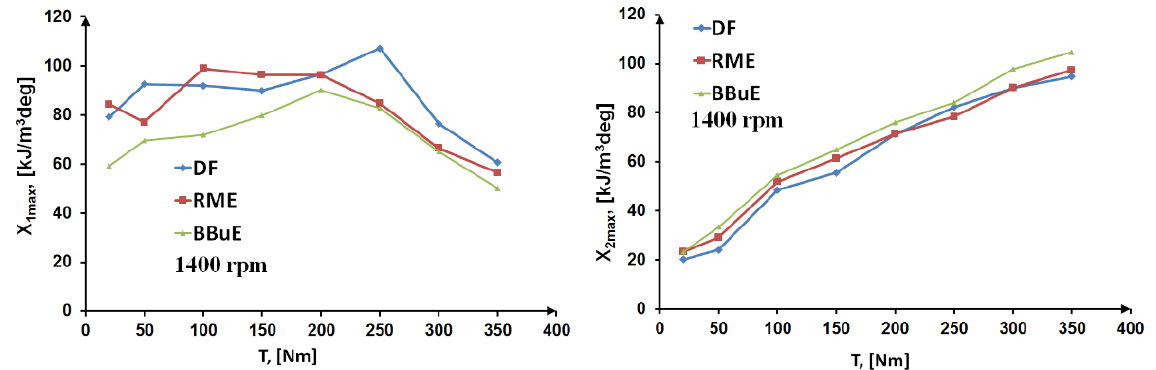
Figure 13. Maximum values of the first rate of heat release during the combustion process occurring according to the kinetic mechanism x 1max and the second rate of heat release during the combustion process occurring according to the diffusion mechanism x 2max when the engine is operated according to the load characteristics at a crankshaft speed of 1400 rpm and fed with the tested fuels.